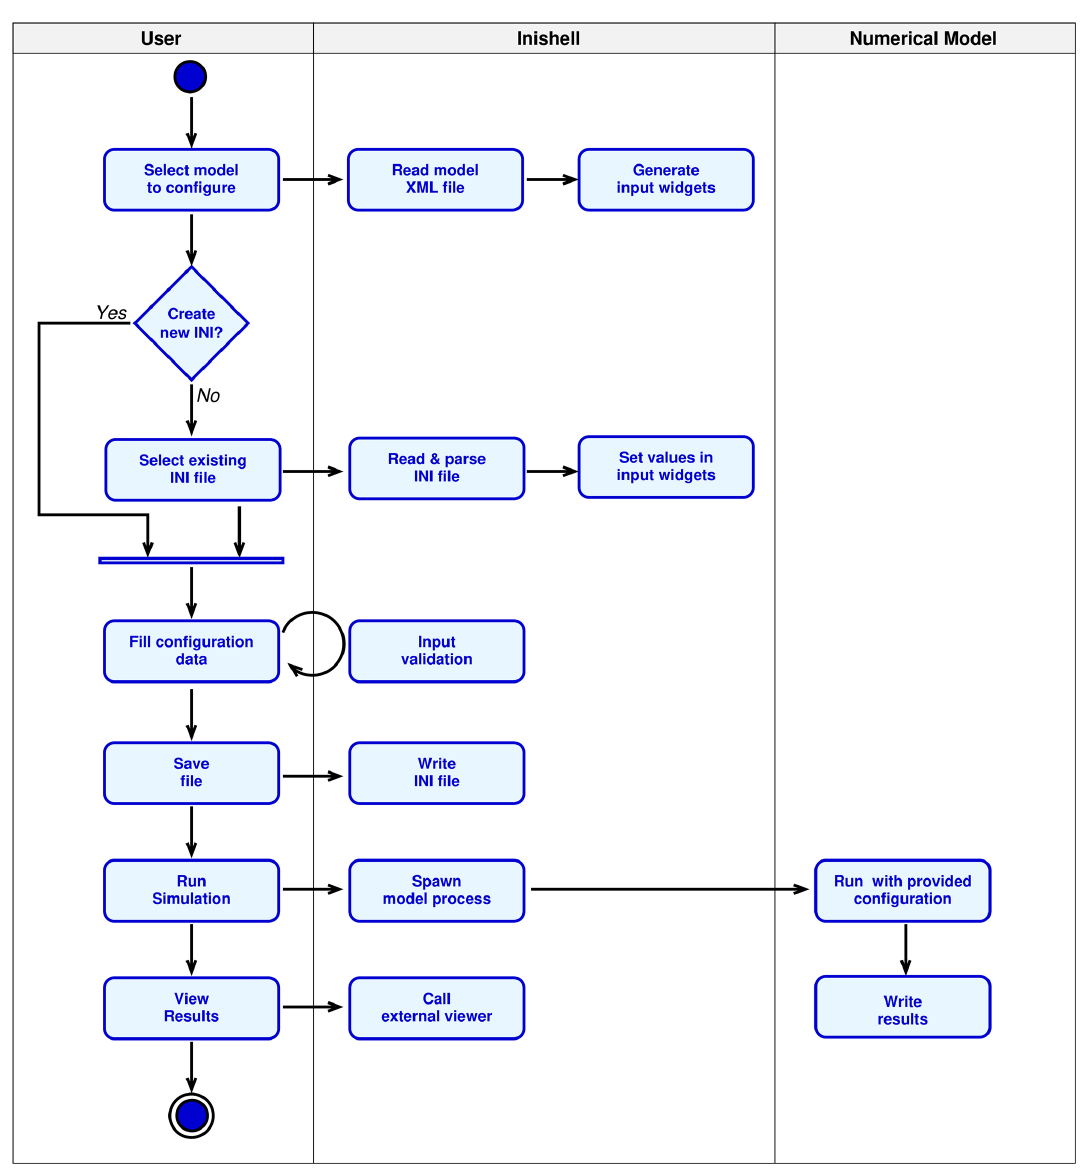
Figure 3. Inishell end user workflow: activity